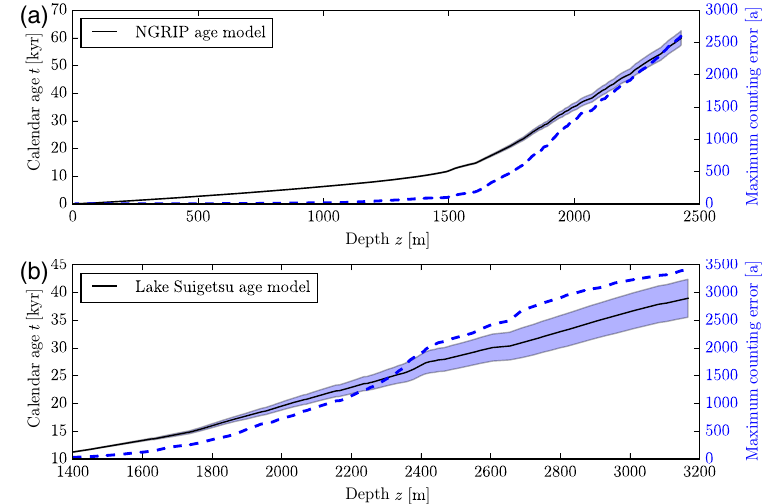
Figure 2. NGRIP and Suigetsu age models. (a) The age–depth relation of GICC05 for the NGRIP ice core (solid black line) (Andersen et al., 2006; Rasmussen et al., 2006). The associated uncertainties are quantified as the maximum counting error (MCE), given in years corresponding to annual layers; they are depicted as blue shading around the age–depth relation, and additionally as the blue dashed line with scale shown on the right-hand side. In this chronology, uncertain layers are counted as 1 / 2 ± 1 / 2 years (Andersen et al., 2006; Rasmussen et al., 2006), which implies that the MCE is half the number of uncertain layers. Note the change in slope at the transition from glacial to interglacial conditions, which reflects the substantial increase in dating uncertainties at this point, due to changing accumulation rates and increasing pressure in the ice. (b) The age–depth relation of the varve-counted segment of the Suigetsu lake deposit record. Note how the uncertainties increase monotonically for both records, because the counting process causes them to accumulate toward the